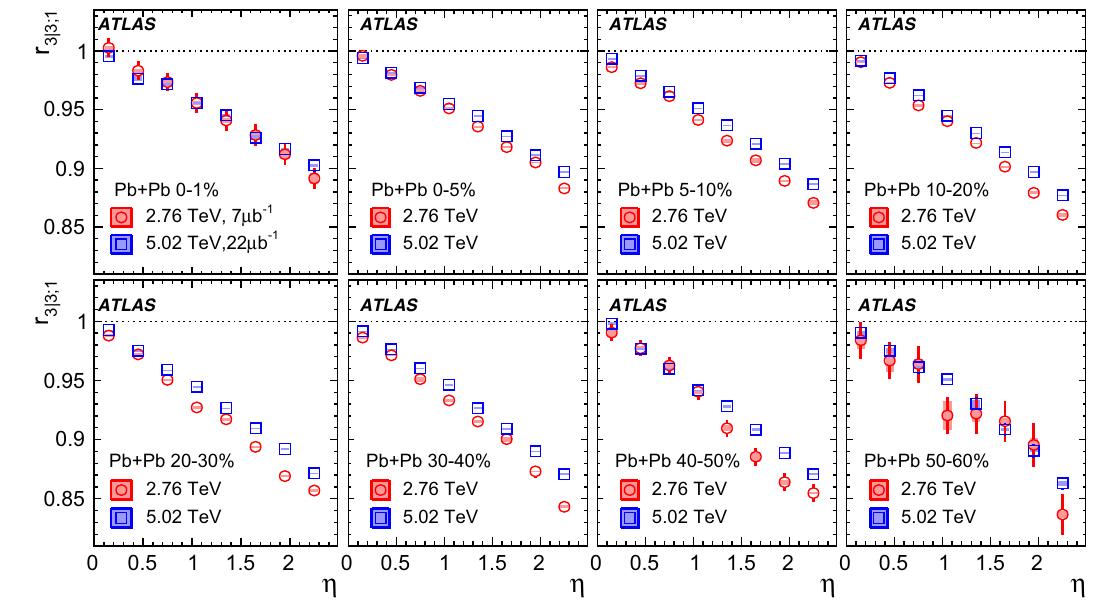
Fig. 7 The r 3 | 3 ; 1 (η) compared between the two collision energies. Each panel shows results from one centrality interval. The error bars and shaded boxes are statistical and systematic uncertainties, respectively 1 4 ; 4 | r